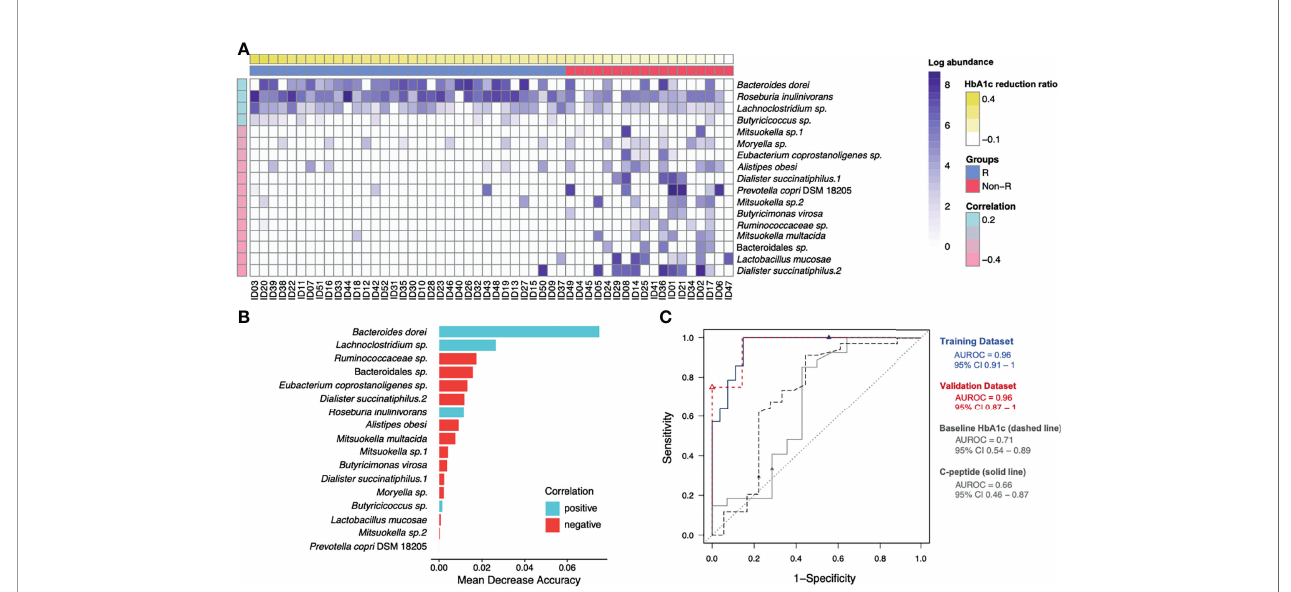
FIGURE 3 | Identi fi cation of glycemic response-associated microbial signatures for GLP-1 RA treatment. (A) Based on the heatmap, the log-transformed abundance of 17 microbial features were signi fi cantly correlated with blood glucose reductions. Samples are in a sequence of the HbA1c reduction levels across the x-axis and 17 microbial features are in a sequence of their correlation coef fi cient values ( P < 0.05, Pearson ’ s correlation) in the y-axis. Purple grading in a cell represents the log-transformed abundance of the microbial feature. Responders (R) and non-responders (Non-R) are colored in blue and red, respectively. (B) The selected 17 distinct features were plotted by their mean decrease accuracy scores, based on random forest model. The higher the value of mean decrease accuracy score was, the higher importance of the microbial features in the model ranked. (C) The ROC curves illustrate the diagnostic ability of the microbial signatures, baseline HbA1c and C-peptide (areas under the ROC curves equal to 0.96, 0.71 and 0.66, respectively). HbA1c, glycohemoglobin; ROC, receiver-operating characteristic.